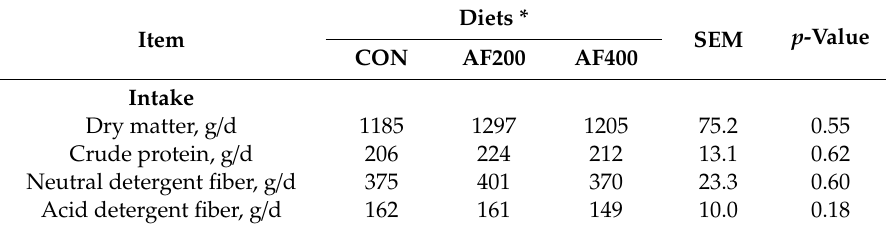
Table 5. Intake of nutrients in Awassi lambs fed diets containing alternative feeds (AF). Diets * Item SEM p -Value CON